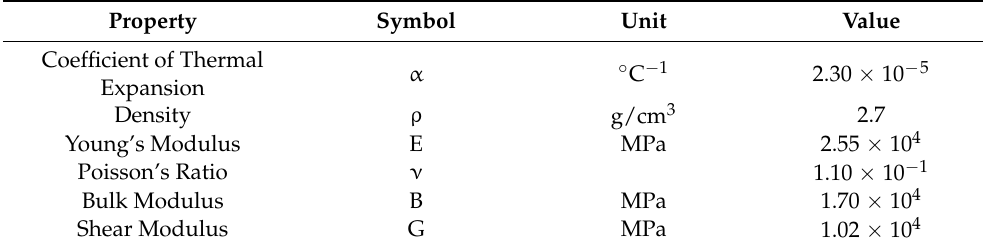
Table 3. The physical and elastic properties of housing and cover material.